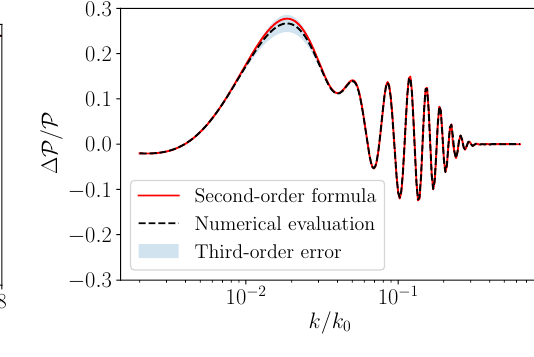
Figure 4: Numerical evaluation of the power spectrum using the reconstructed ∆ ε/ε shown in Fig. 3, which reproduces the exact power spectrum to within an ac- / ) 3 curacy of ( ∆ P R P R